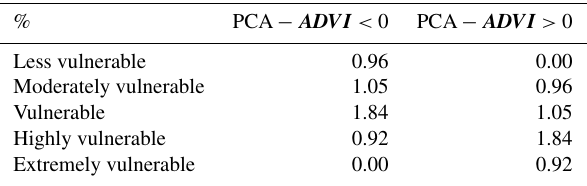
Table 2. Percentage of pixels of each vulnerability class, cal- culated from the PCA, corresponding to the difference equal to PCA − ADVI < 0 and PCA − ADVI >